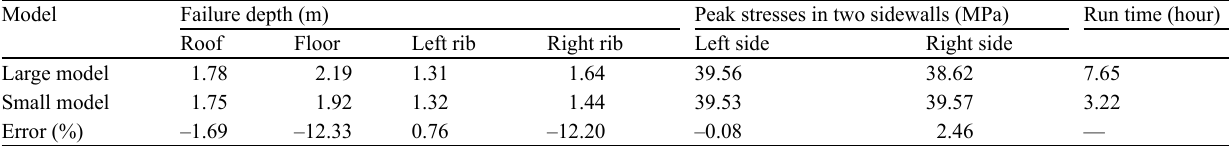
Table 1 Comparison between the simulation results of small and large models Model Failure depth (m) Peak stresses in two sidewalls (MPa) Run time (hour) Roof Floor Left rib Right rib Left side Right